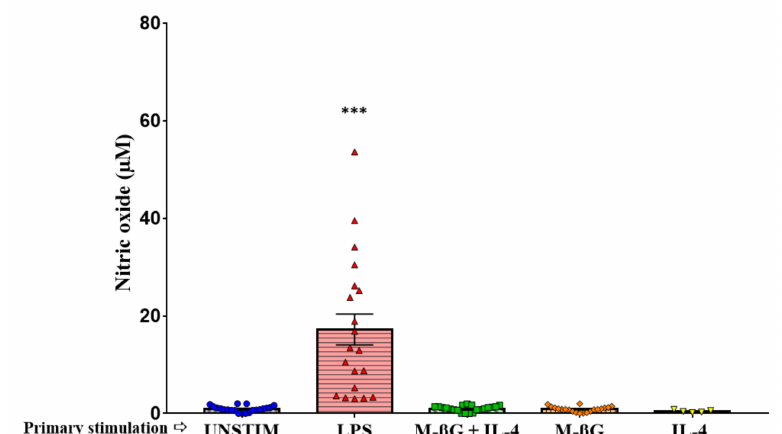
Figure 3. Primary stimulation with LPS resulted in enhanced nitric oxide production. Fresh isolated adherent cells were primary stimulated with culture medium (UNSTIM), LPS (10 µ g / mL), M- β G (10 µ g / mL), M- β G + IL-4 (10 µ g / mL + 100 ng / mL) or IL-4 (100 ng / mL). LPS induced NO production ( N = 21 chickens; N IL-4 = 5 chickens). Each bar represents mean ± SEM. *** p < 0.001.